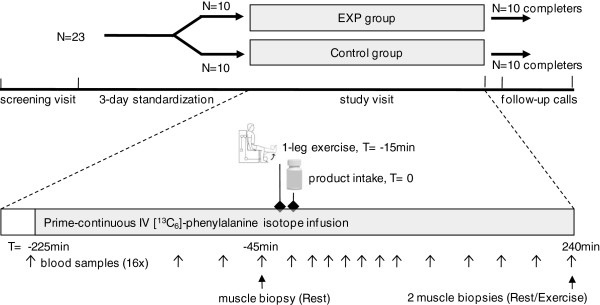
Study design. Study design, including a screening visit, a 3-d standardization period, study visit and follow-up calls. At the study visit, participants underwent a stable isotope infusion protocol for 7¾ h, including an initial fasting period of 3¾ h until product intake (T = 0), regular blood sampling (arrows), 3 muscle biopsies (T = -45 and 240 min), and an unilateral resistance exercise intervention (T = -15 min).